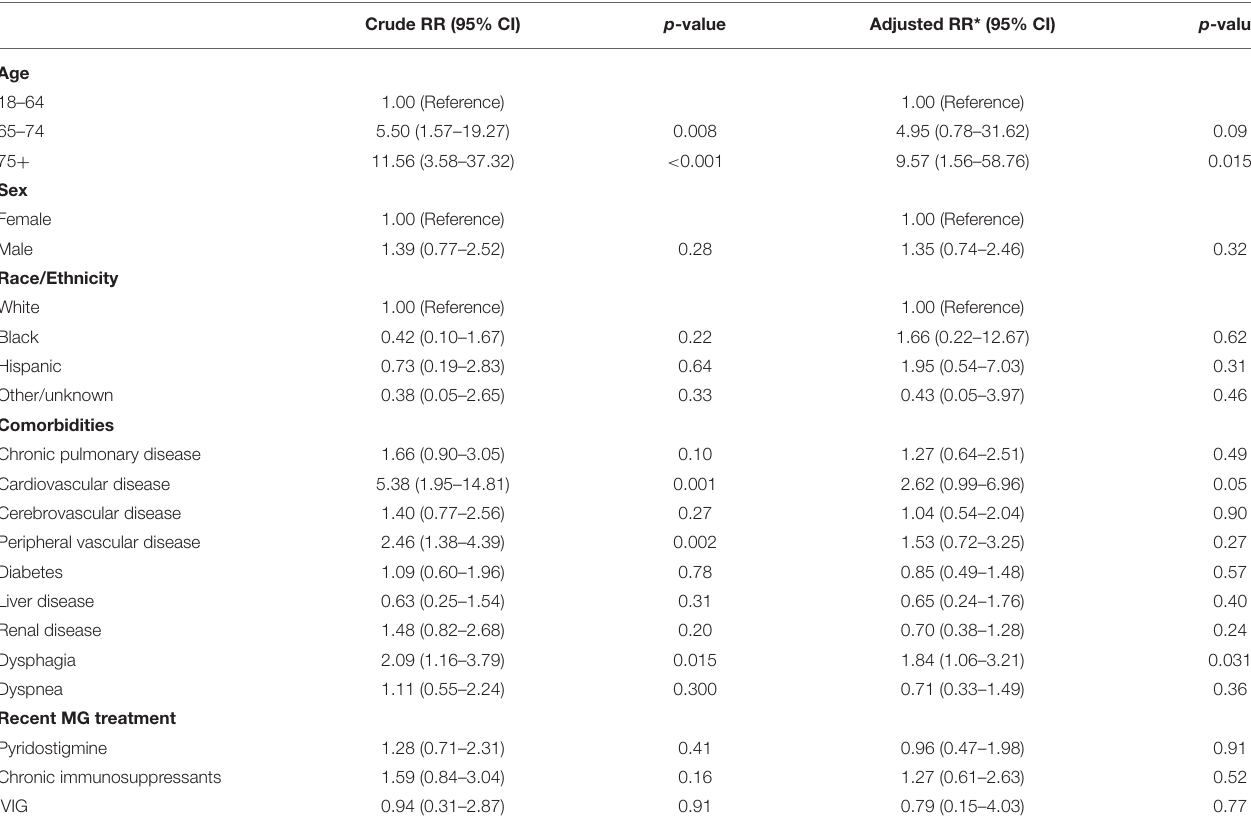
TABLE 3 | Factors associated with mortality in COVID-19 with myasthenia gravis